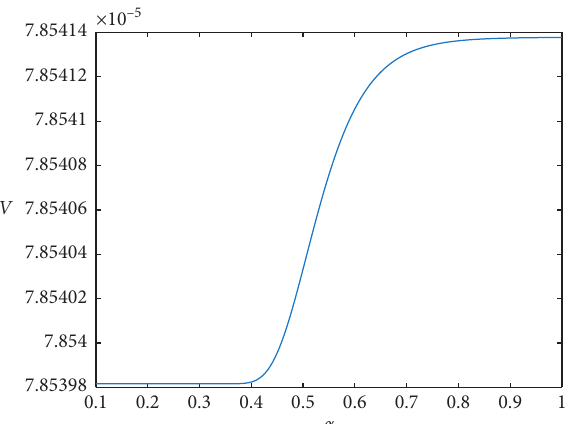
Figure 5: Relationship between fractional order and stroke volume � 0 . 4 , 􏽥 c � 0 ) . ( R � 1 . 25 × 10 − 2 ,u max